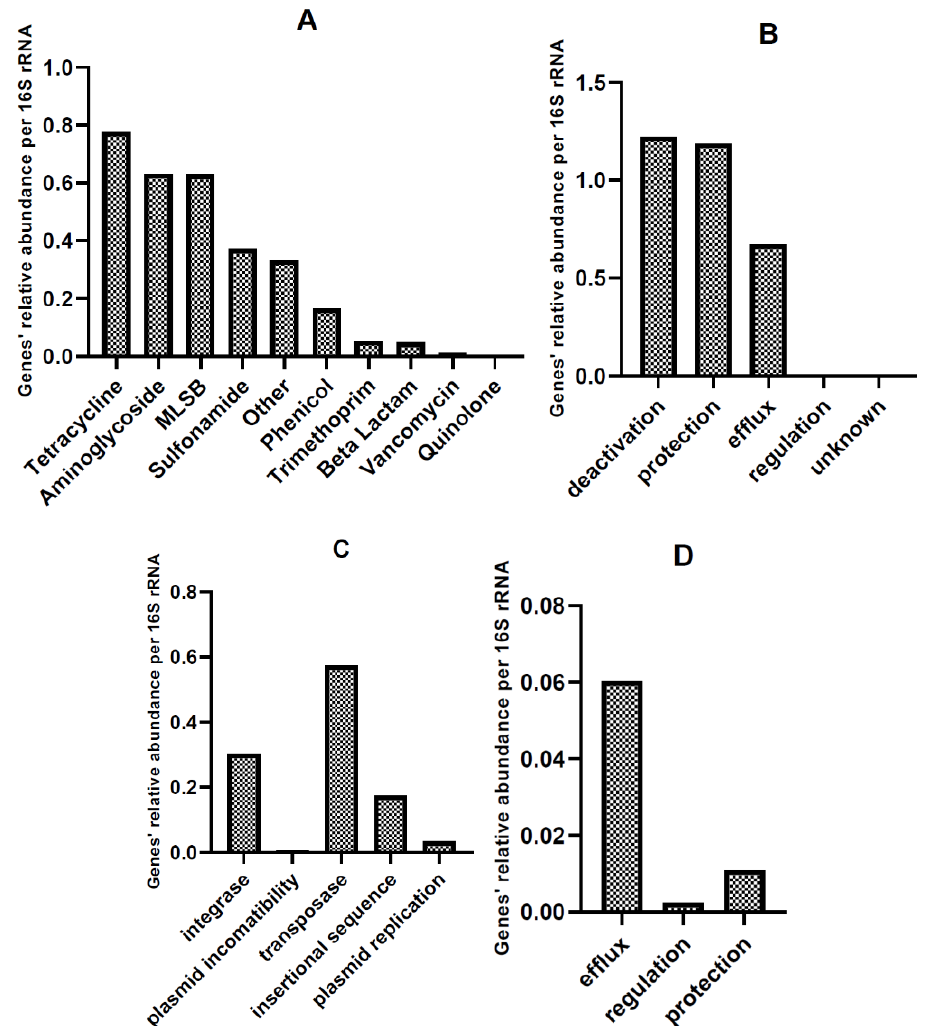
Figure 7. Distribution of ARGs, presented as mean values for all chicken waste samples, categorized as the following: ( A ). gene classes, ( B ). mechanisms of resistance, ( C ). mechanisms related to MGE, ( D ). mechanisms related to MDR identified in the analyzed chicken waste samples .